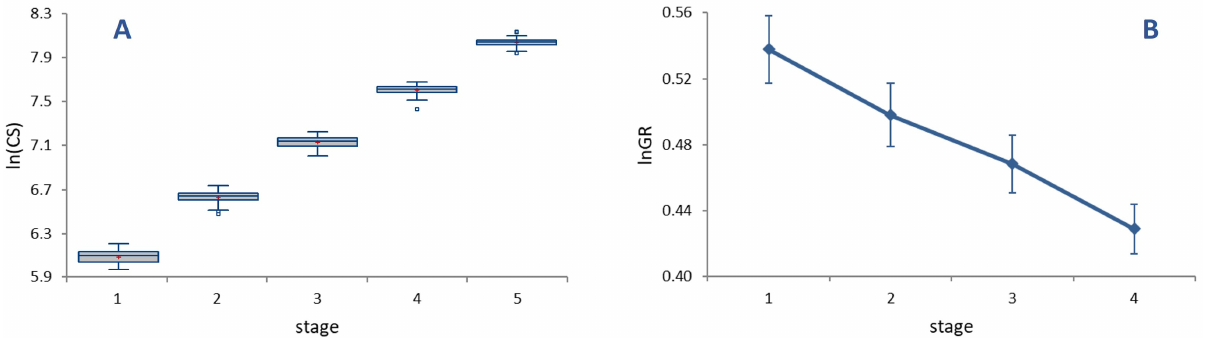
Figure 2. ( A ) Ontogenetic progression of size ( lnCS ) during the five larval stages in P. brassicae . Boxes represent the interquartile interval, with median (transverse line) and mean (red cross); vertical lines are ranges of variation, to the exclusion of outliers (dots). ( B ) Log-transformed per-stage growth rates ( lnGR ). Bars are 95% confidence intervals.